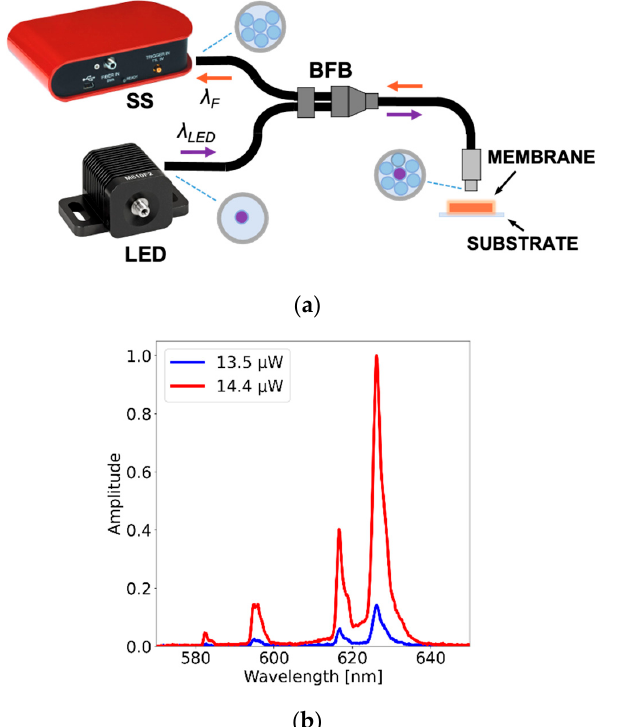
Figure 11. Typical spectral features of a PDMS-GOS:Eu membrane (62.5% wt./wt. concentration, v c = 1000 rpm, t vc = 20 s) as a function of the excitation power. ( a ) The setup used for spectral acquisition includes a bifurcated fiber bundle (BFB), an LED (340 nm) and a solid-state spectrometer (SS). ( b ) Fluorescence peaks captured with the bundle for two excitation powers (i.e . , 13.5 and 14.4 μ W) registered with the BFB (see text for further details).